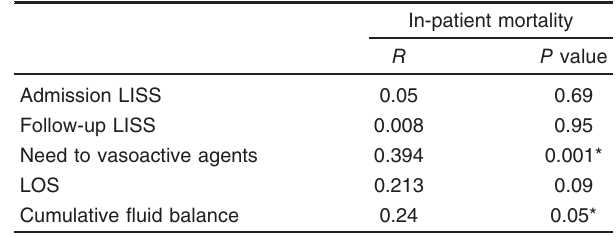
Table 2 Comparison between two studied groups in different outcome parameters